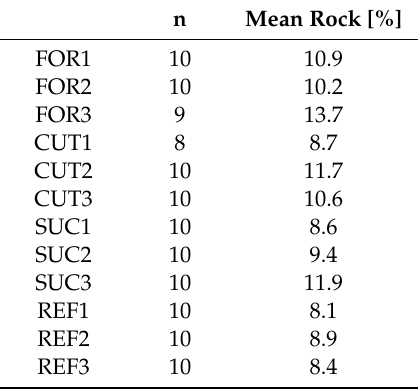
Table 7. Rock content of every catena; (FOR)ested, (CUT)-down, (SUC)cession, (REF)orested.